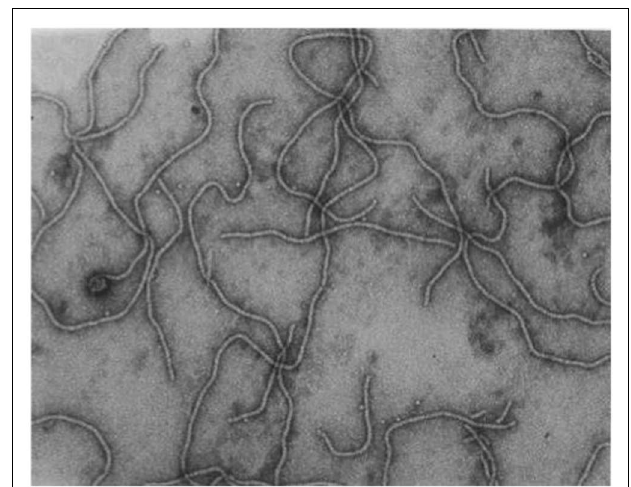
FIGURE 3 |Transmission electron micrograph of negatively stained, purified GLRaV-3 particles, using 1% (w/v) aqueous uranyl acetate staining. Picture taken by G. G. F.